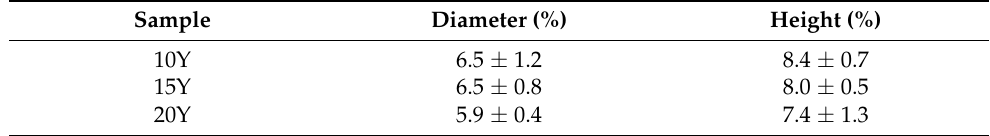
Figure 2. Viscosity of suspensions 10Y, 15Y, and 20Y at different shear rates ( a ) and different temperatures ( b ). After sintering, the shrinkage ranged from 5.9% to 6.6% and from 7.4% to 8.4% for the diameter and height of the samples, respectively (see Table 2). Due to the anisotropic pore structure, the shrinkage was similarly anisotropic. The green density of the initial samples affected the sintering shrinkage [24]. Hence, samples with higher solid loading and higher green density experienced less sintering shrinkage. Table 2. Summary of the shrinkage of the samples after sintering at 1400 °C for 4 h.